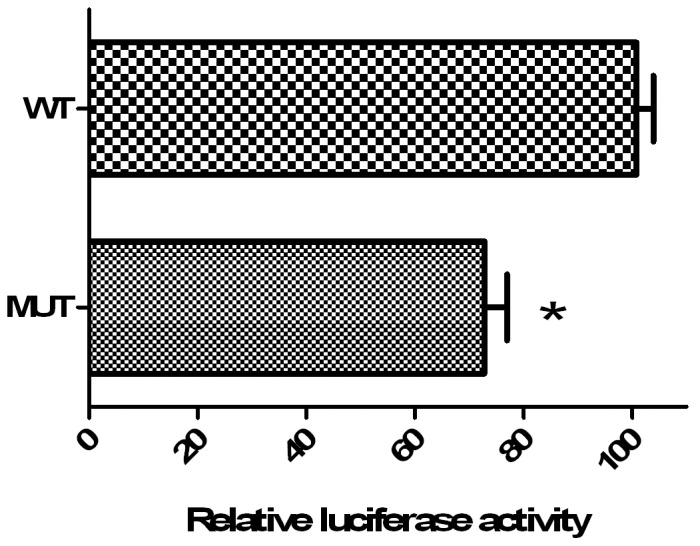
Relative Luciferase activity.Three independent assays were performed by triplicate and data represent means±SD. 24 h after transfection MUT constructs containing the +3725C variant shown lower (p = 0.0001) activity than wild-type 3′UTR construct (WT); The relative firefly Luciferase activities were normalized against β-gal.